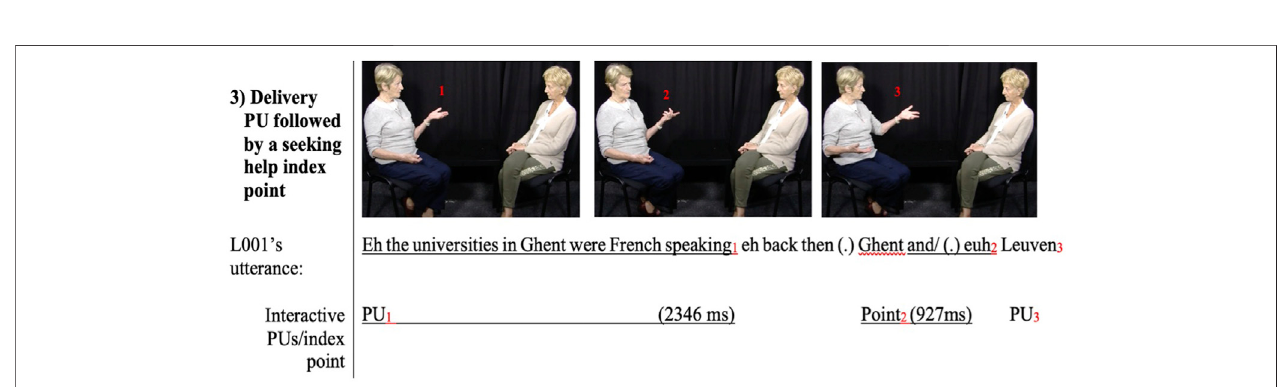
FIGURE 6 | Delivery PU and seeking help index by L001 (FRAPé Corpus, 03:42.099-03:48.827).